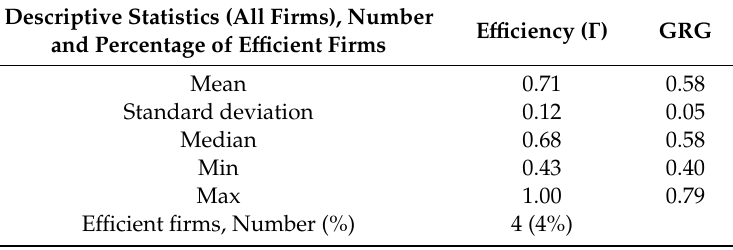
Table 7. Descriptive statistics of range adjusted measure (RAM) of e ffi ciency ratings, number, and percentage of e ffi cient firms.